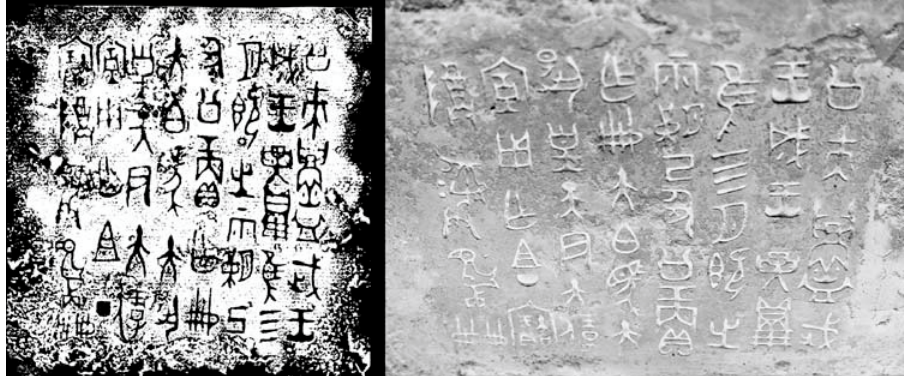
Figure 6. Inscriptions on two vessels (from a set of medium-scale Zuoce Da tetrapod bronze ding with hewen “ yiding ”), Western Zhou period, ca 11th century BCE. Sources: Freer Gallery rubbing (left) from Pope 1967 vol. 1: pl. 34; rights courtesy of the Hermitage Museum and Gardens, Sloane Collection, Norfolk, Virginia, 50-G-11. Figure 1. Masked semi-human figures with arms raised. ( A ) Yi 異 graph; ( B ) Displayed yi image, probably Kui; ( C ) Simplified displayed yi